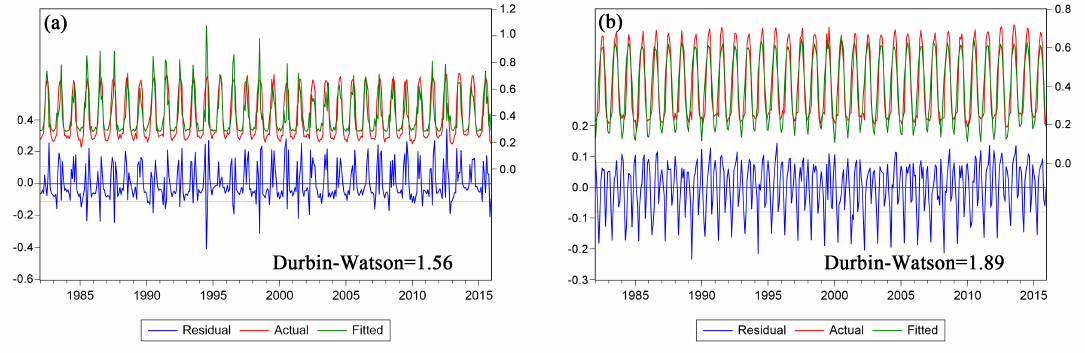
Figure 5. Results of the Engle–Granger cointegration test for the non-stationary sequence between NDVI-P ( a ) and NDVI-T ( b ) in the